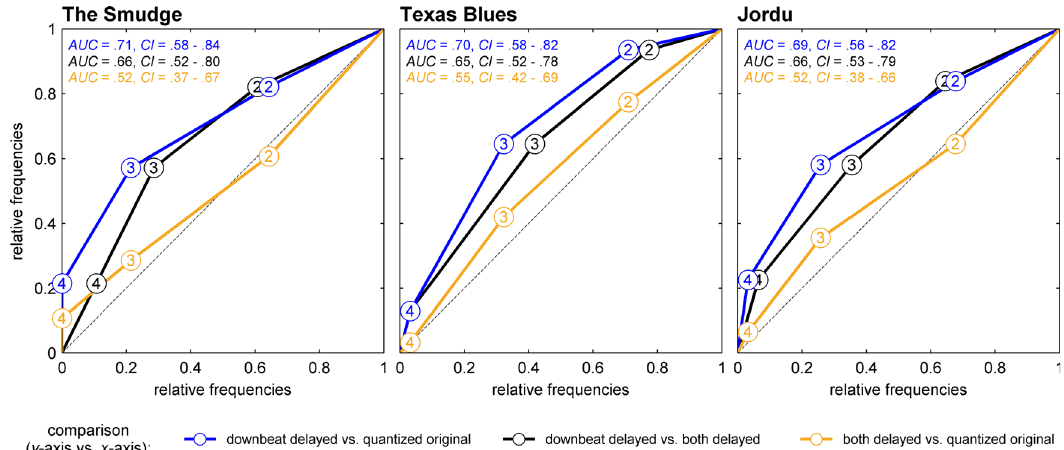
Fig. 5 Receiver operating characteristic (ROC) curves for the swing ratings of three pieces. These curves compare cumulative proportions of the ratings 4 to 1 for two conditions mapped along the horizontal and the vertical axis, i.e., two of the stacked histograms of Fig. 4 are plotted against each other along an axis each. A deviation from the diagonal to either side indicates higher swing ratings for one of the conditions and shows that listeners discriminate between the versions. The area under the curve ( AUC ) quanti fi es the deviation from the diagonal ( AUC = 0.5 means no discrimination). Comparison of the downbeat delayed with the quantized original manipulation (blue curves) and with the both delayed manipulation (black curves) shows a signi fi cant preference for the downbeat delayed versions. Statistical signi fi cance is con fi rmed for these two curves by the AUC con fi dence intervals (CI), which do not contain AUC =